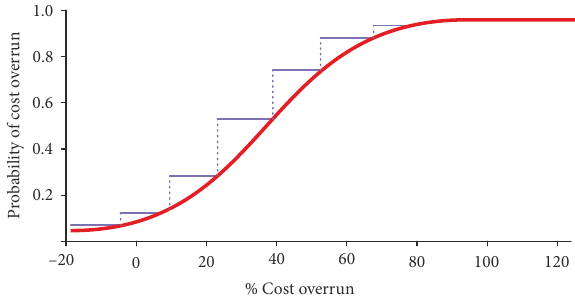
Figure 4. PDF for cost overruns